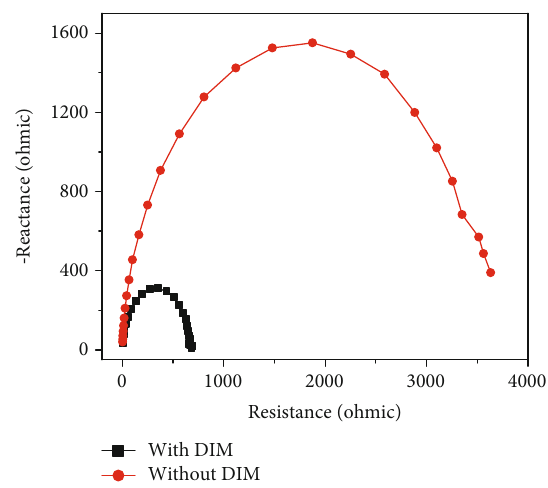
Figure 12: Cole-Cole plots of the PCDTBT:PC processed with and without 3%